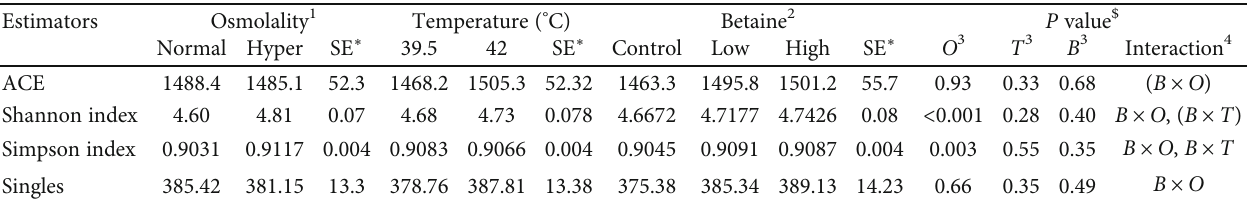
Table 3: Measures of alpha diversity of ruminal archaea community in fermenters associated with the liquid phase as determined using QIIME and 16S rRNA